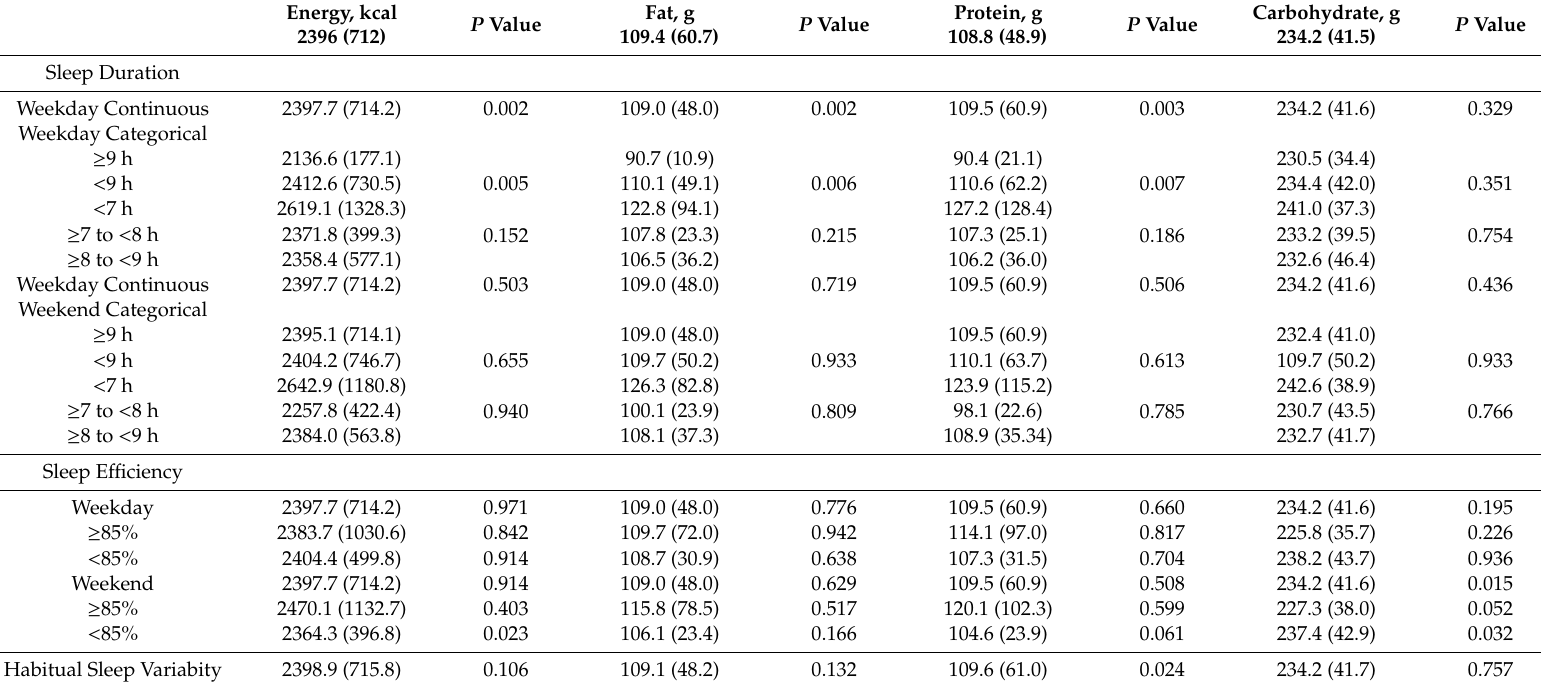
Table 2. Dietary intake according to actigraphic sleep